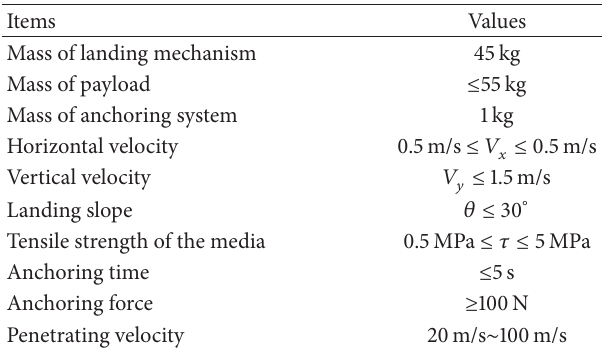
Table 2: Mechanical and landing performance parameters.